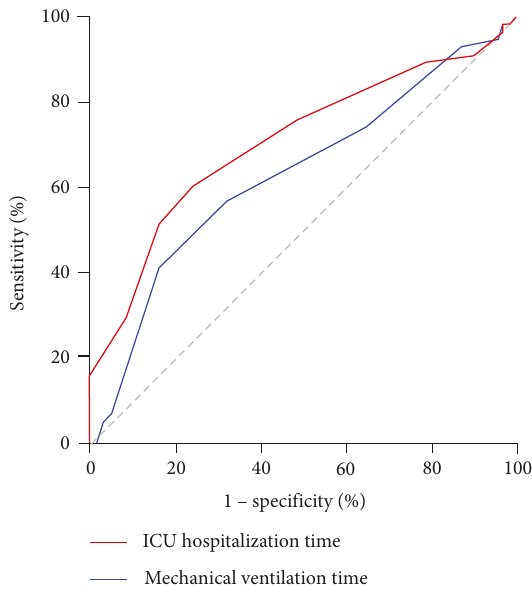
Figure 4: ROC curve for diagnosis of